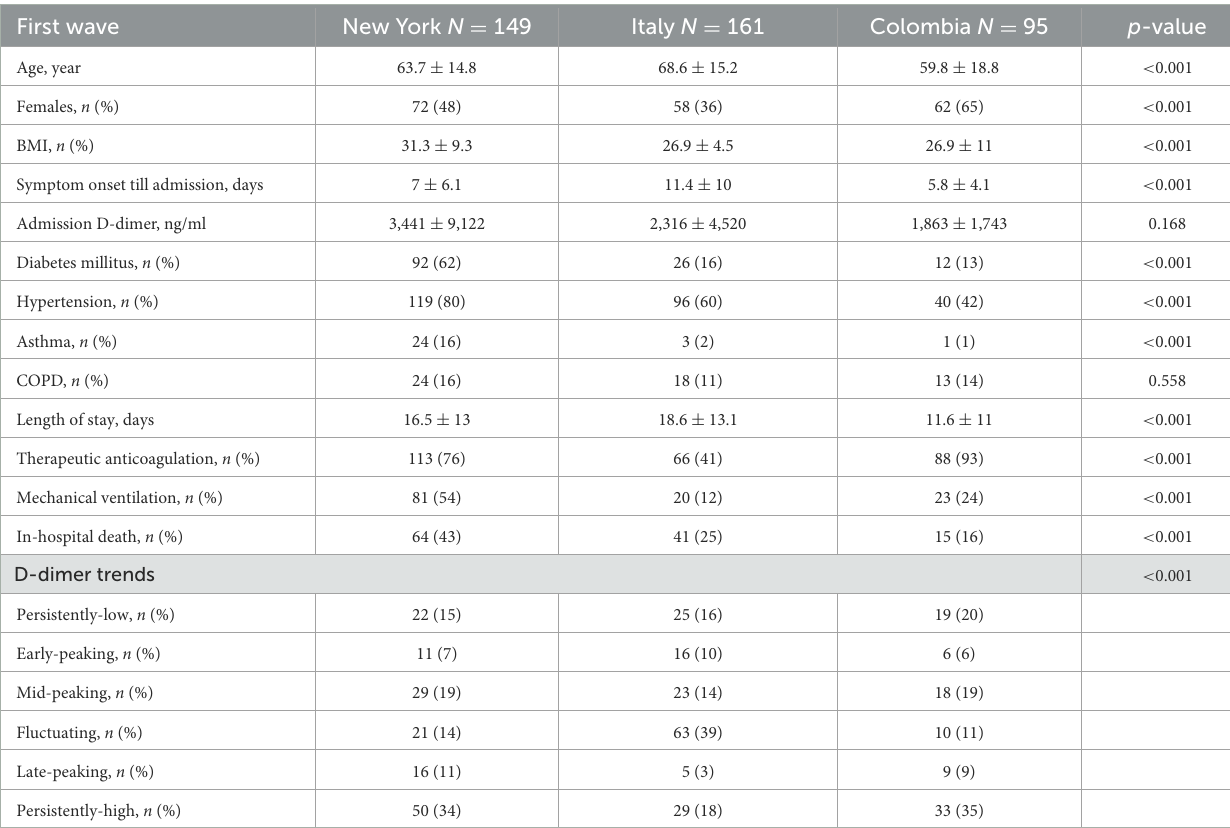
TABLE 2 Comparisons between different study sites during the first